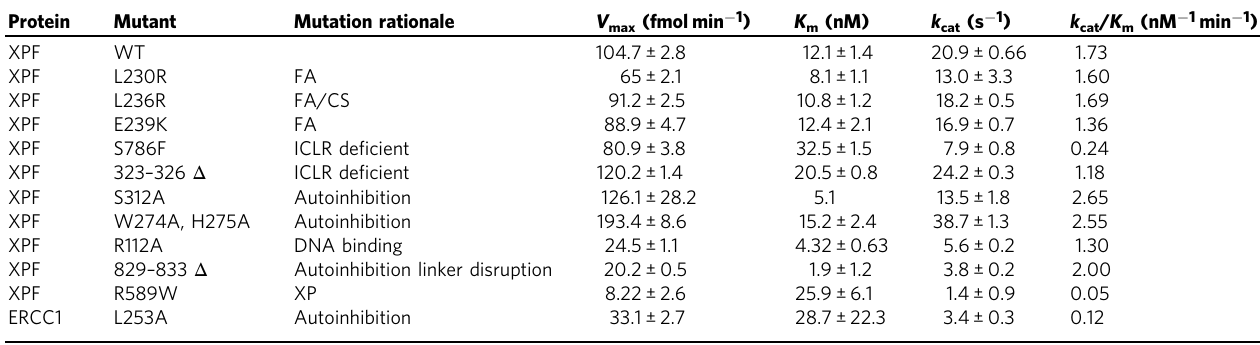
Table 2 Kinetic data for puri fi ed XPF – ERCC1 mutants. Protein Mutant Mutation